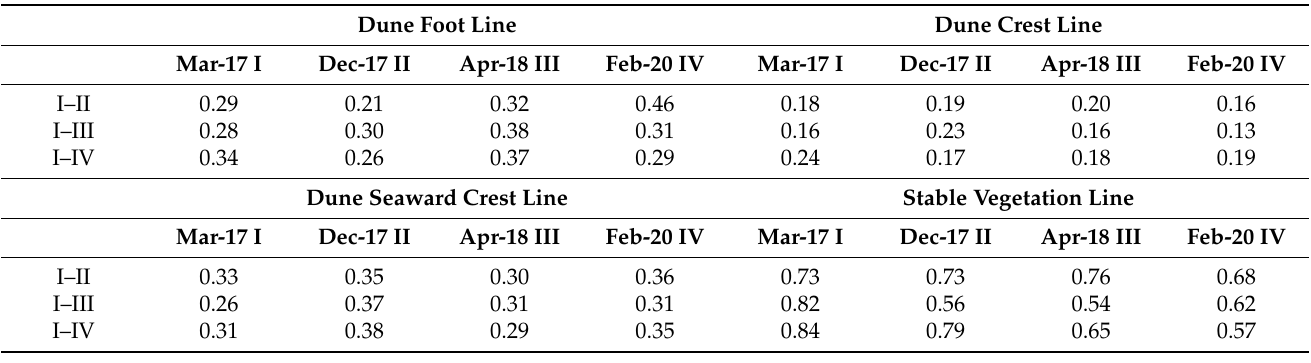
Table 3. Digitising error in m for each couple of lines tested. Roman numerals indicate the identification number of the digitisation